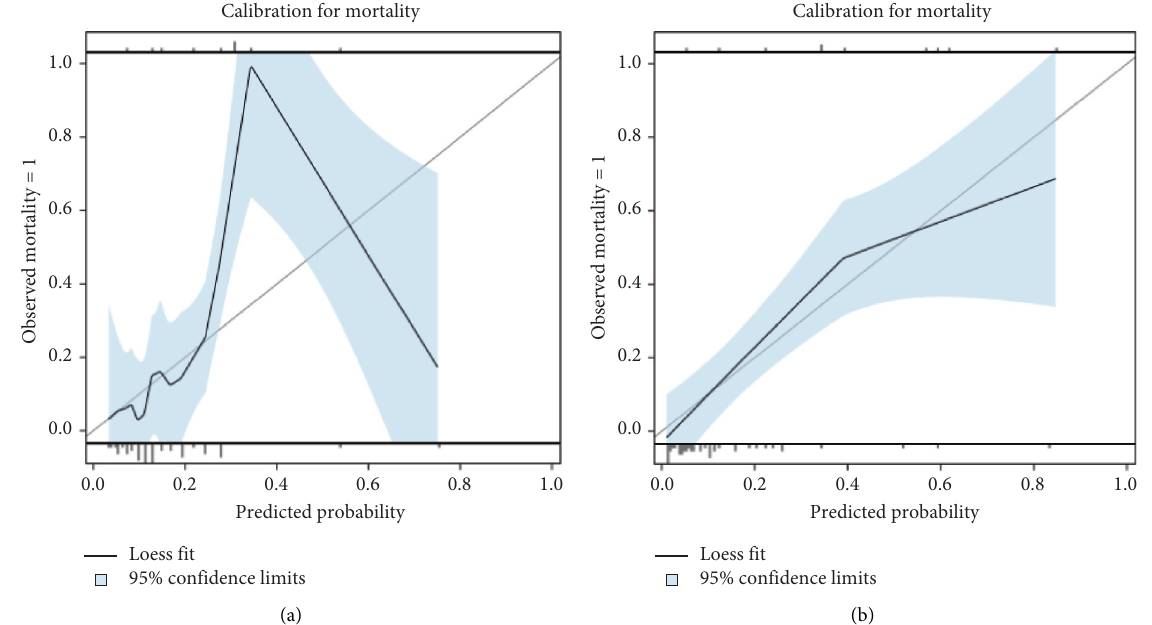
Figure 4: Calibration plots for mortality of subgroup analysis for APACHE II (a) and APACHE IV